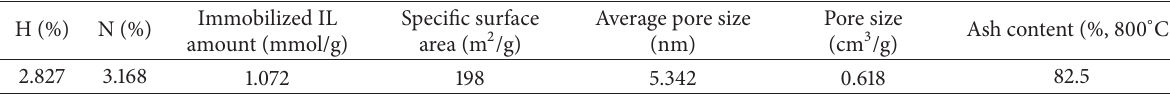
Table 1: Main related parameters of SiO 2 ⋅ Im + ⋅ OH − .